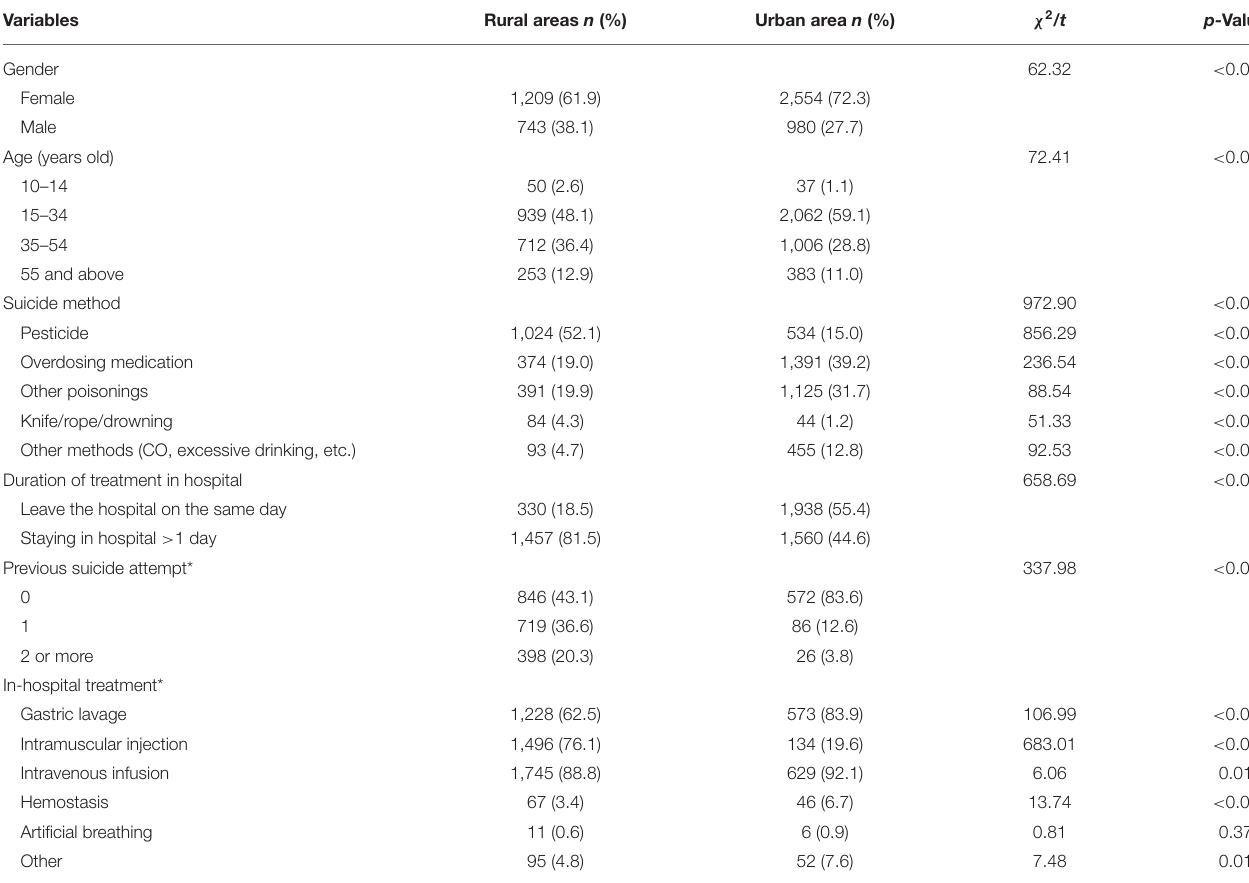
TABLE 1 | Comparison of demographic variables and characteristics of suicide attempts registered in rural and urban hospitals.